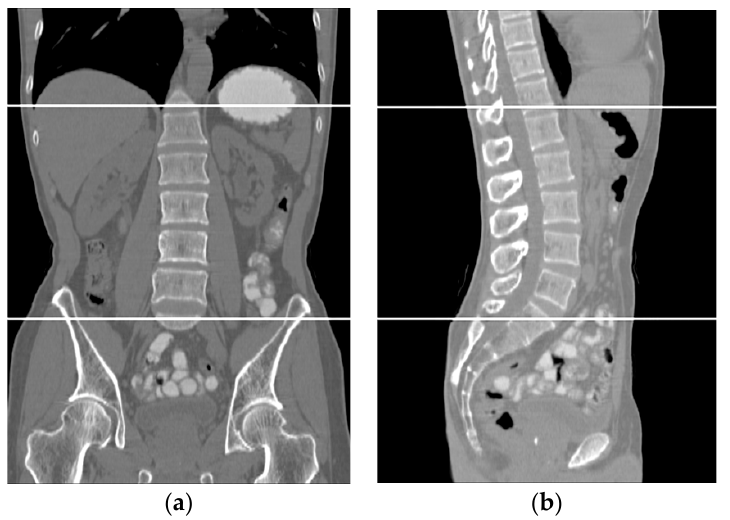
Figure 12. Two samples show the area where the CT slices are selected from. ( a ) Front view, ( b ) side view.